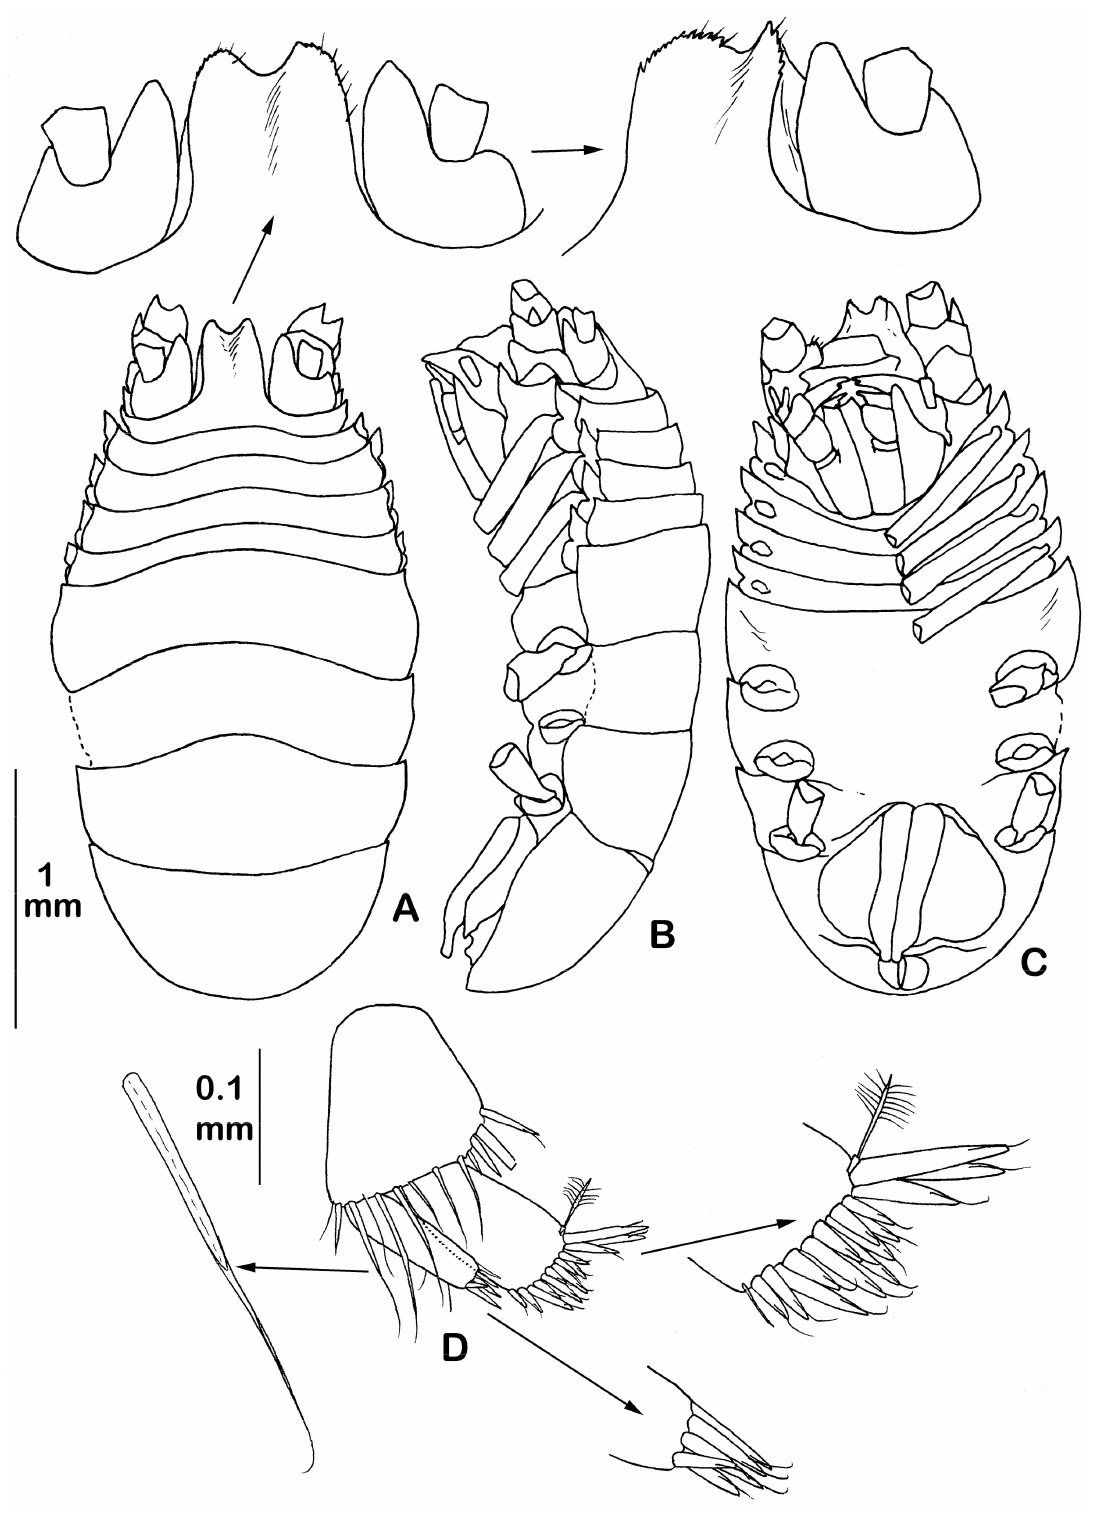
Figure 22. Eurycope gordeyi sp. nov. Male holotype (ZMH K-45636): ( A ) dorsal view (rostrum and antennae I enlarged); ( B ) lateral view; ( C ) ventral view. Male paratype (ZMH K-45645): ( D ) uropod (distal parts